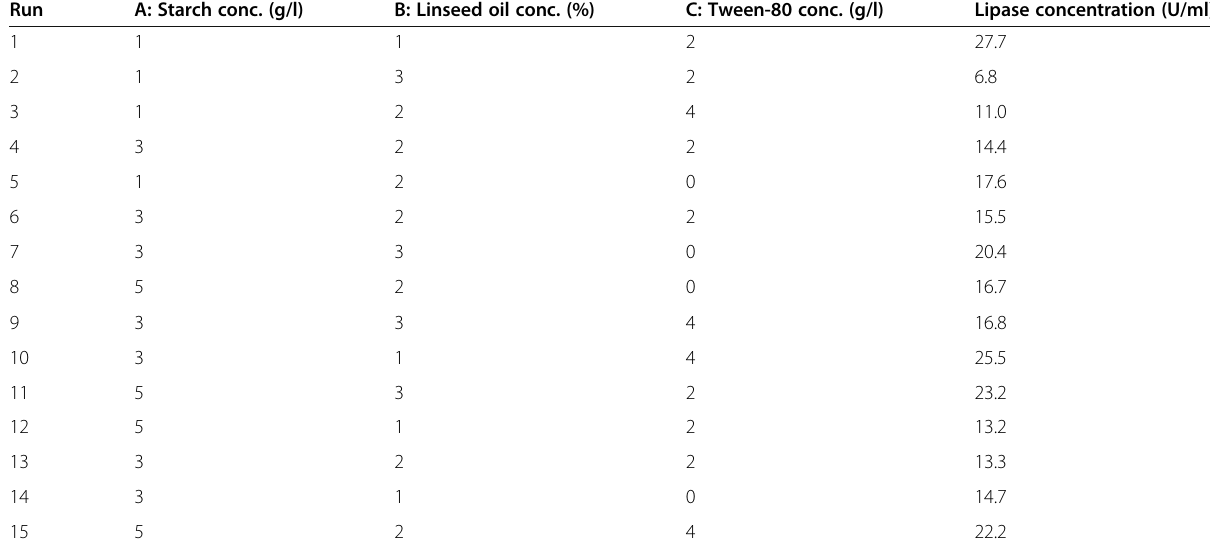
Table 4 Box-Behnken design for modulating the effects of starch, linseed, and Tween-80 concentrations on lipase production by Streptomyces sp. SBLWN_MH2